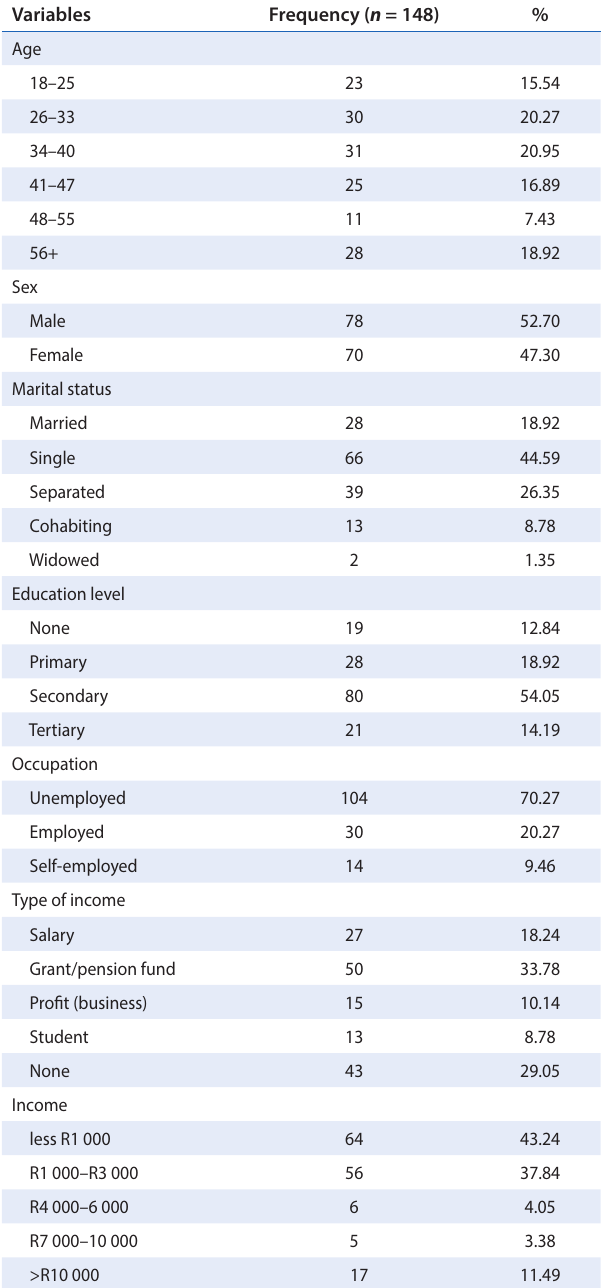
Table 1: Socio-economic and demographic characteristics.